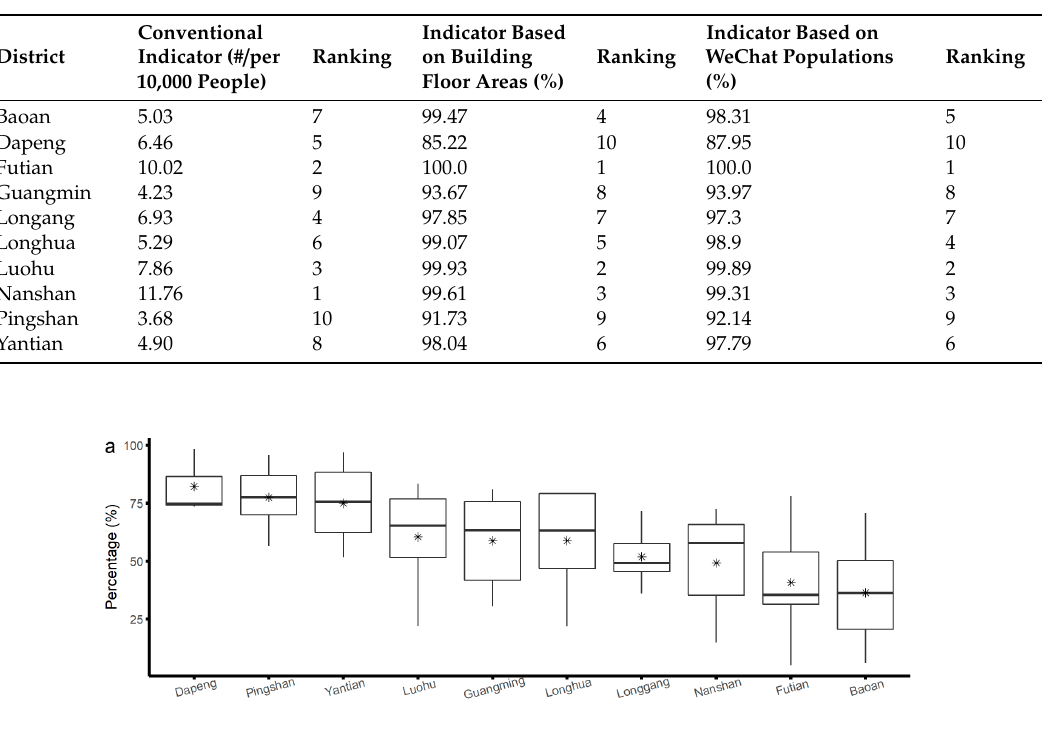
Table 5. Rankings of districts by the indicator of leisure and recreation.